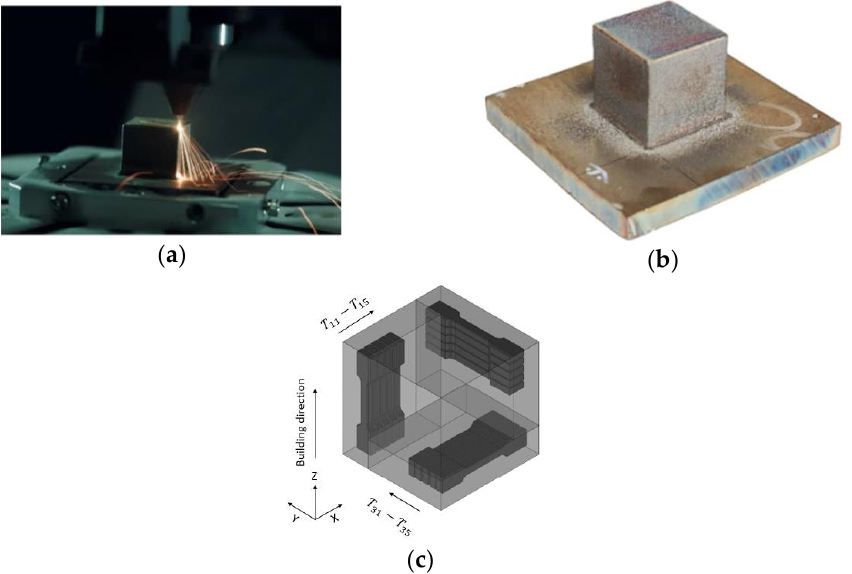
Figure 1. Manufacturing of cube by DED: ( a ) mounted cube throughout fabrication: ( b ) post fabri- cated cube; ( c ) tensile test